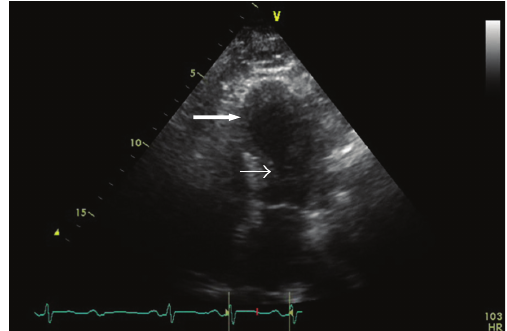
Figure 3: Transthoracic echocardiogram. The patient’s apical four- chamber transthoracic echocardiogram at end systole showing left ventricle, left atrium, and mitral valve. There is left ventricular basilar contraction (small arrow), with near apposition of the endomyocardium, and severe apical hypokinesia (large arrow) with apical ballooning.